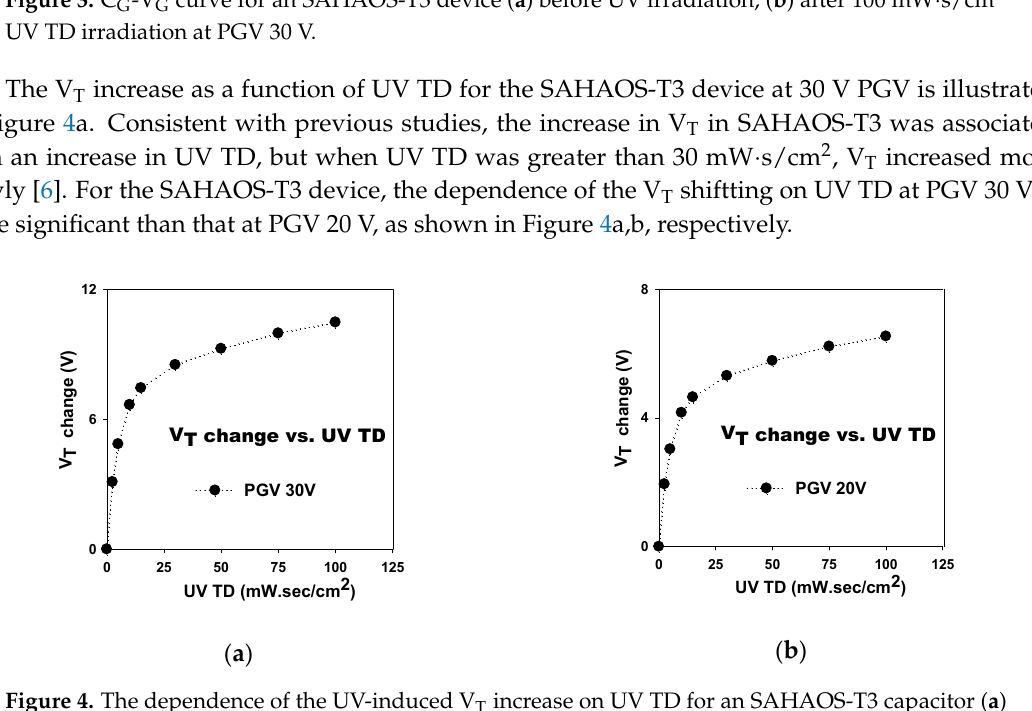
Figure 3. C G -V G curve for an SAHAOS-T3 device ( a ) before UV irradiation; ( b ) after 100 mW · s/cm 2